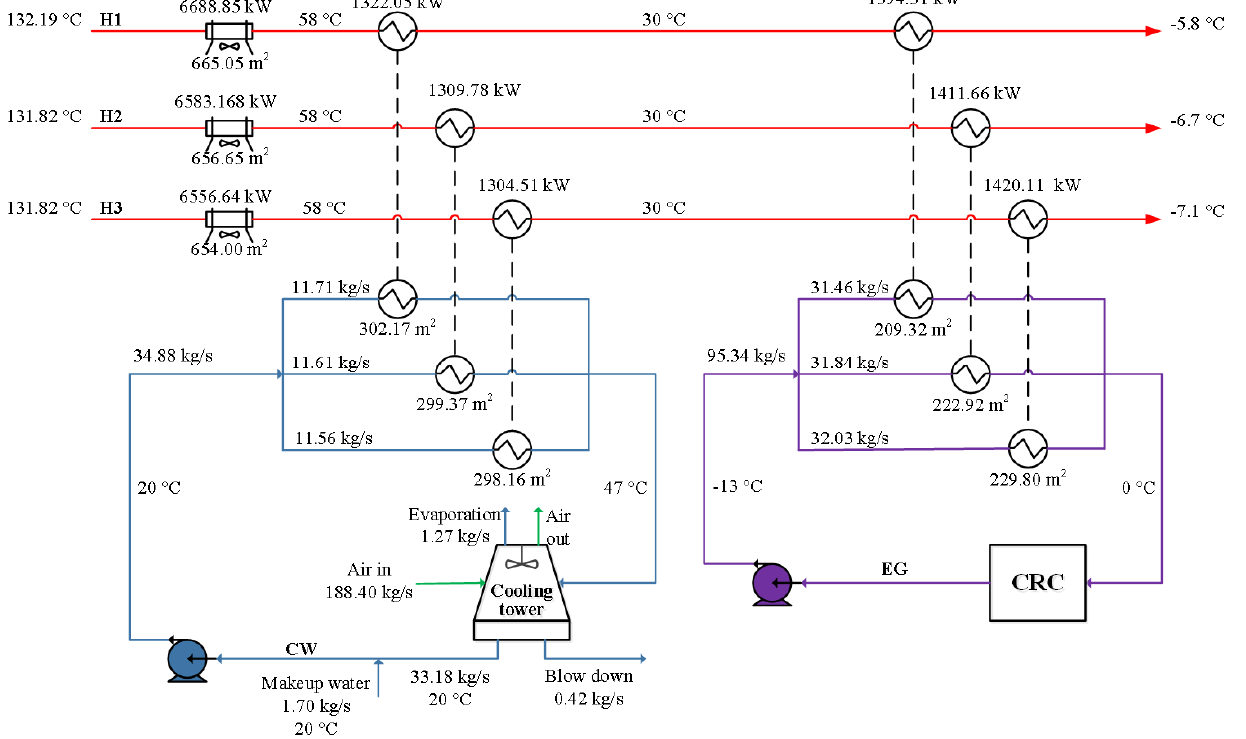
Figure 6. The base-case cooling system of hot streams.